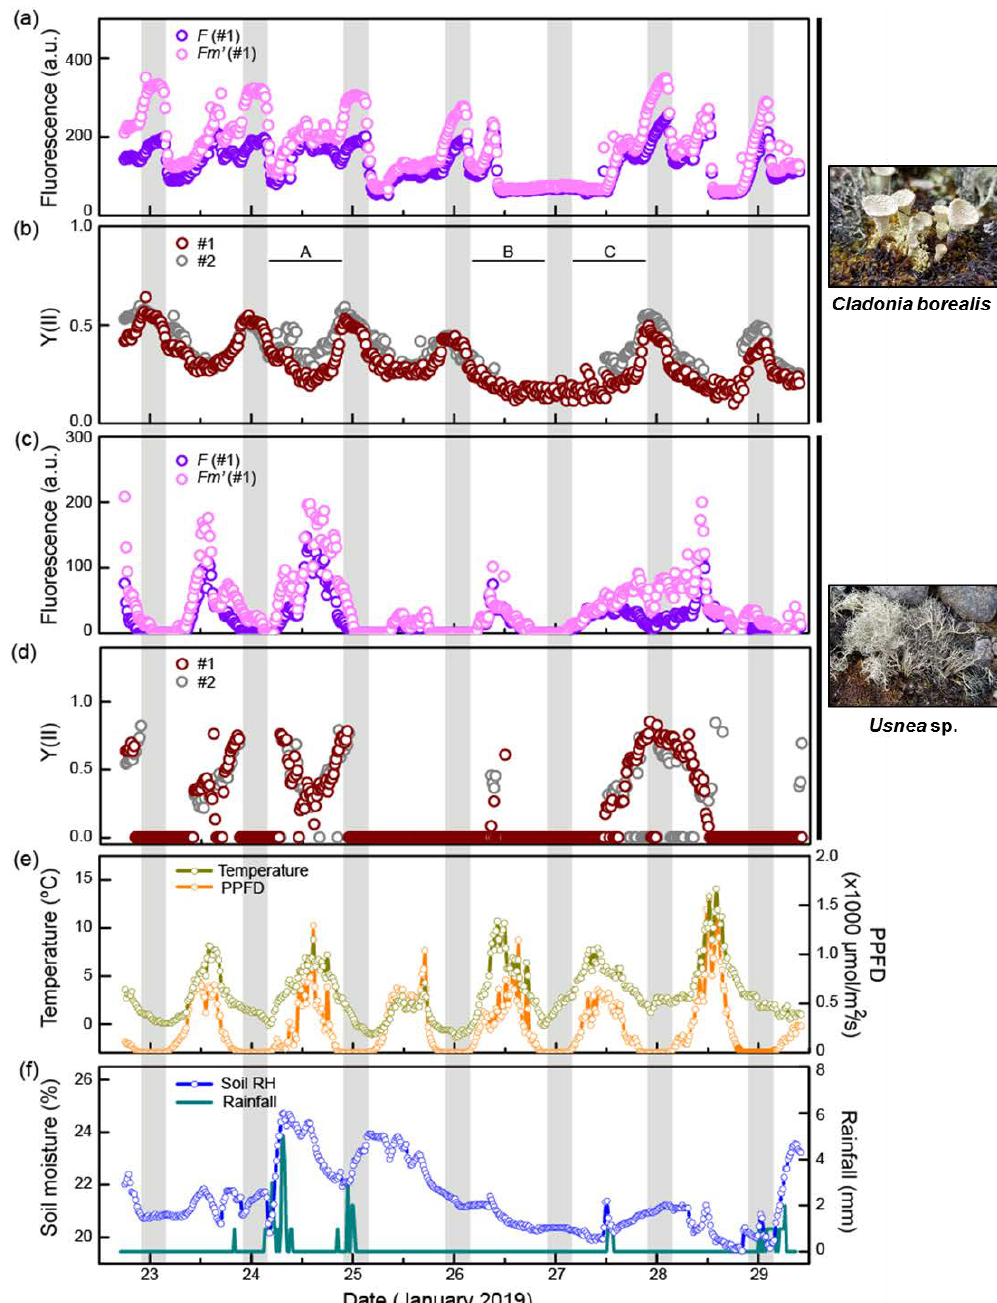
Figure 2. Field observation of the fluorescence ( F and Fm ’) and Y(II) value of C. borealis and Usnea sp. and microclimate at the site. Grey shading indicates nighttime (10 PM to 4 AM) when photosynthetic photon flux density (PPFD) was less than 10 µ mol / m 2 / s. ( a , b ) Fluorescence and Y(II) value of C. borealis ( c , d ) Fluorescence and Y(II) value of Usnea sp. Data were obtained from two individual thalli (Samples #1, #2). Patterns of fluorescence ( F and Fm ’) of C. borealis and Usnea sp. were similar between the two samples. ( e ) Changes in temperature ( ◦ C) and PPFD ( µ mol / m 2 / s). ( f ) Changes in volumetric soil moisture (%) and rainfall (mm) during the observation period. F , current fluorescence; Fm ’, maximum fluorescence.